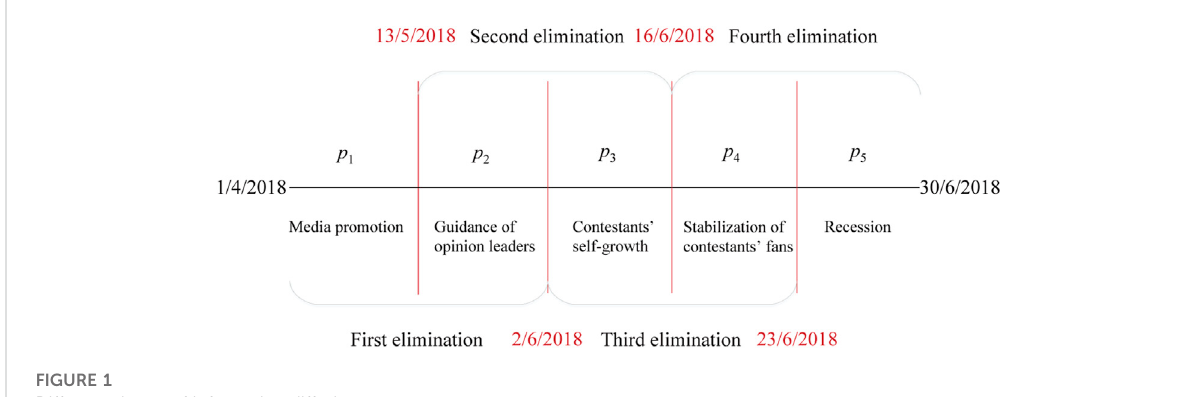
FIGURE 1 Different phases of information